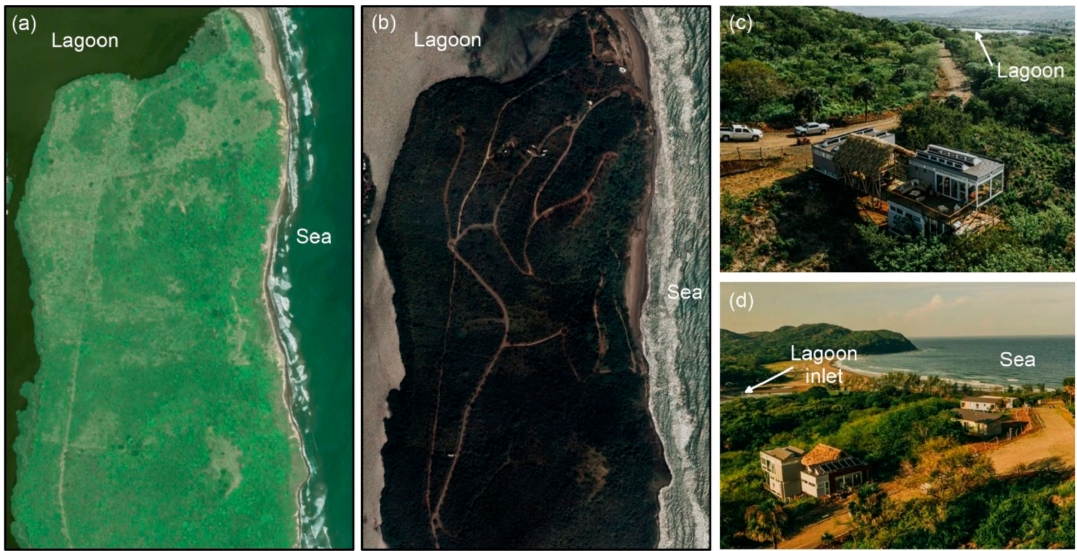
Figure 7. The area of the urban project in La Mancha (Area A in Figure 1): ( a ) in 2017, before construction (adapted from Google Earth); ( b ) in 2021, with new roads (adapted from Google Earth); ( c , d ) some of the new houses in the area (adapted from [34,35], respectively).